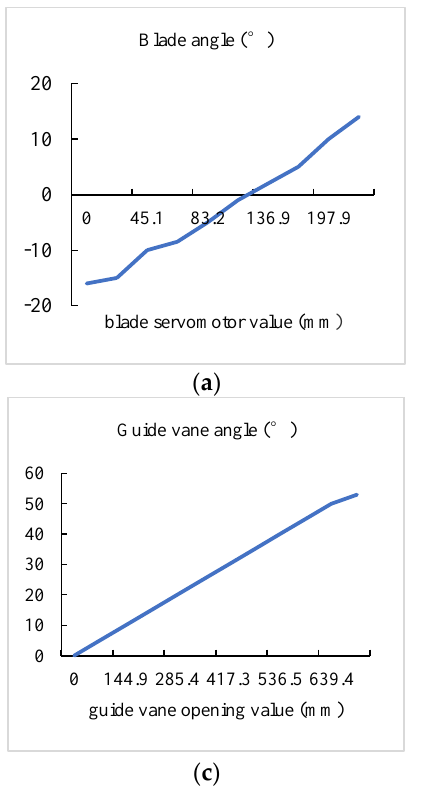
Figure A2. The relationship between blade servomotor value and blade angle ( a ), guide vane FigureA2. Therelationshipbetweenbladeservomotorvalueandbladeangle( a ), guidevaneservomotor